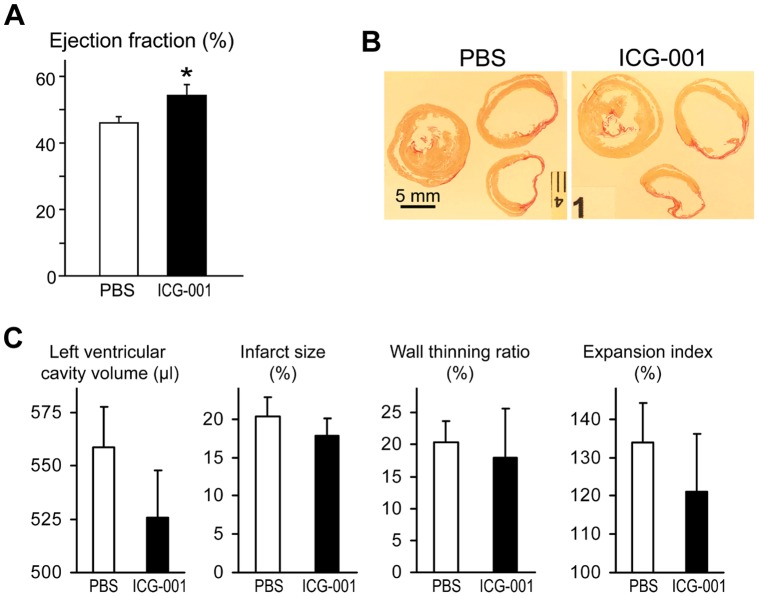
ICG-001 effects on rat myocardial infarction (MI).(A) ICG-001 improved left ventricular ejection fraction at 4 weeks post-coronary artery occlusion. Data are presented as mean ± s.e.m. *P = 0.031 by two-tailed student’s t-test (PBS n = 11, ICG-001 n = 9). (B) Representative transverse sections of hearts at 4 weeks post-surgery. Picrosirius red staining shows a thin collagen rich scar after myocardial infarction. Yellow; muscle, red; collagen. No visible difference in collagen deposition was observed. (C) Left ventricular histomorphometry at 4 weeks post-surgery. ICG-001 insignificantly improved left ventricular cavity volume, infarct size, wall thinning ratio and expansion index. However, no statistical significance was found in this experimental size (P>0.05). Data are presented as mean ± s.e.m.